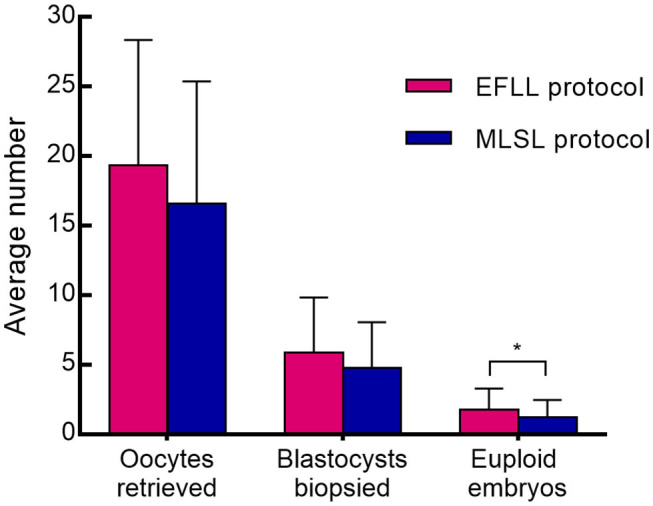
Oocytes retrieved, blastocysts biopsied, and embryos between EFLL and MLSL protocol for PGT-SR. Oocytes retrieved, blastocysts biopsied, and embryos diagnosed as being chromosomally euploidy from patients who underwent PGT-SR cycles using the EFLL protocol and the MLSL protocol, respectively. Values are presented as mean ± standard deviation. *p < 0.05.